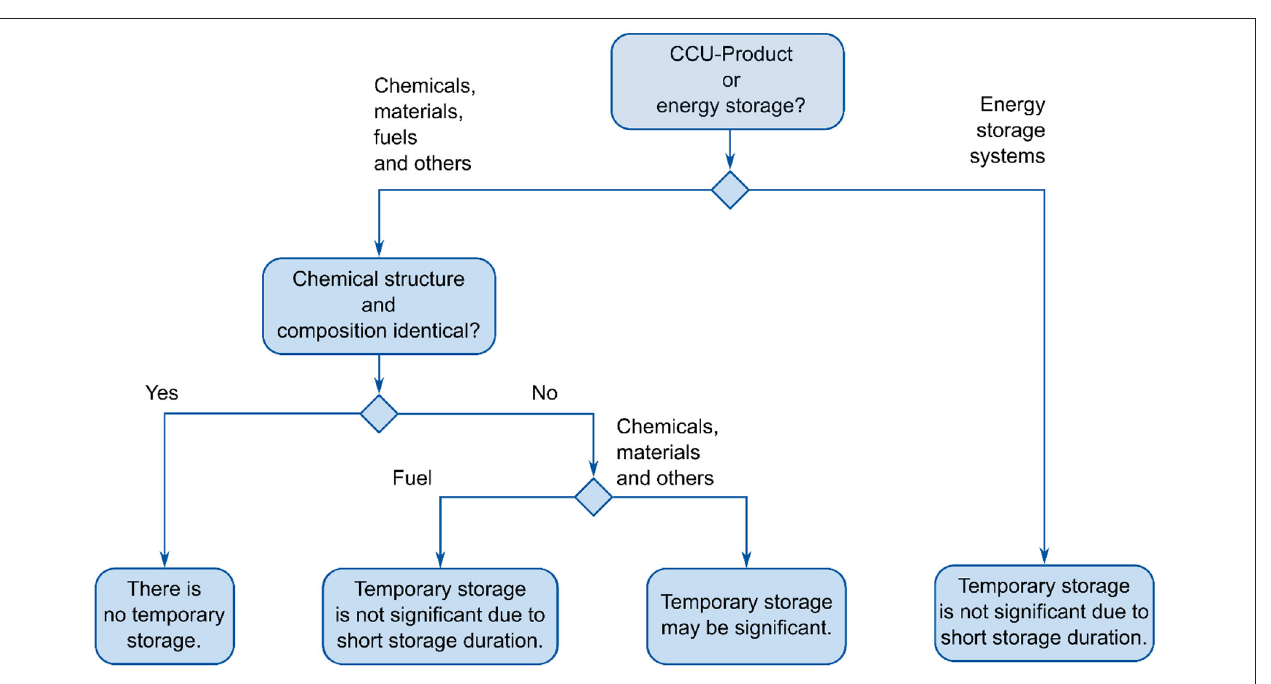
FIGURE 9 | Decision tree for determining if temporary storage is significant for LCA